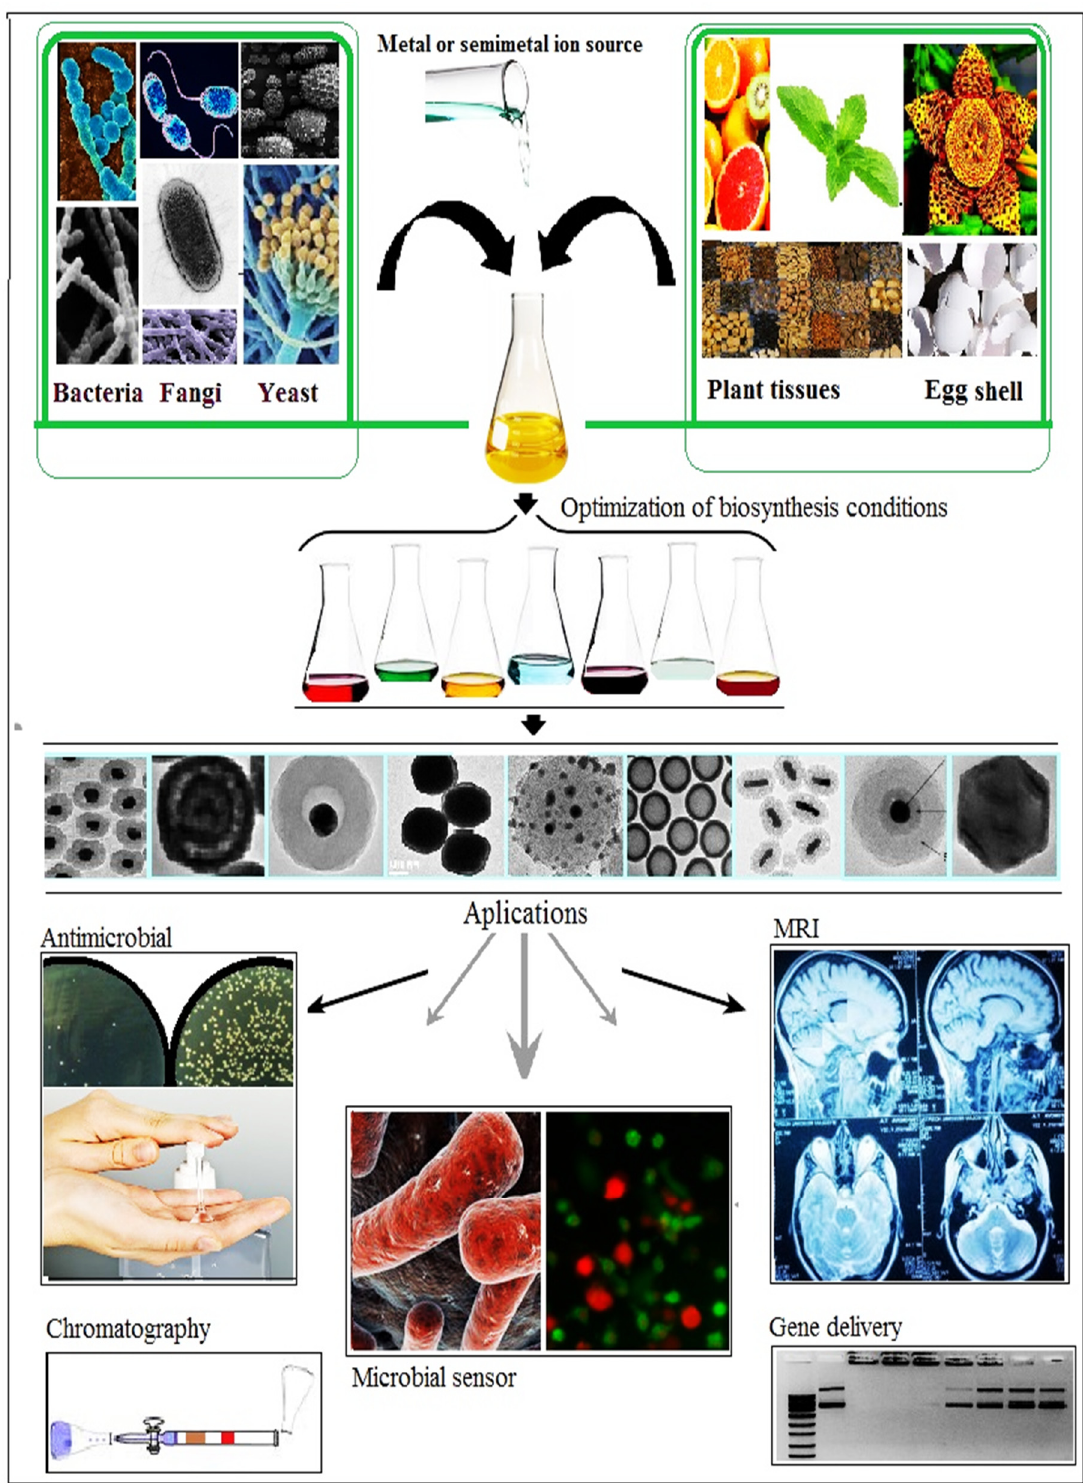
Figure 4. Green Synthesis and applications of core ‐ shell nanoparticles in some biomedical, engineering and environmental Fields.